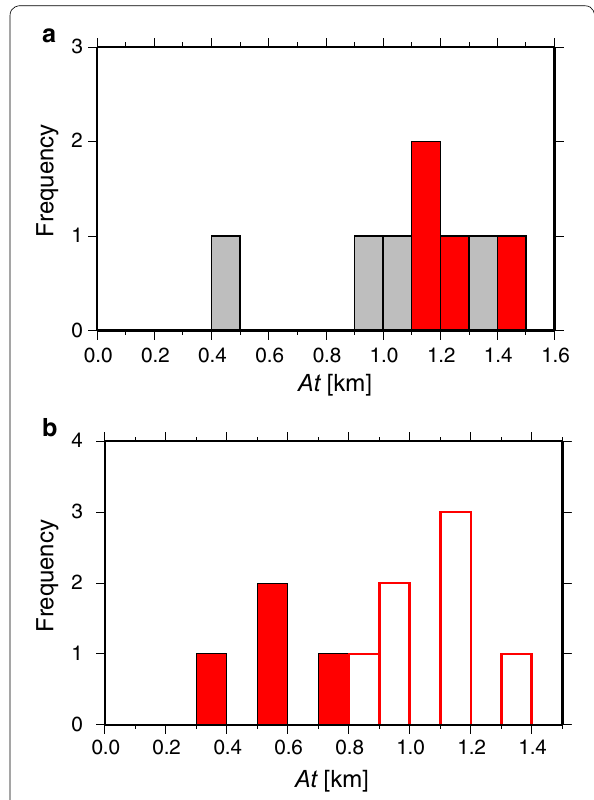
Fig. 7 Histograms showing A t . a Red and gray bins correspond to A t around the mainshock fault (Faults 1 through 4) and the best-fit planes in the northern part of the aftershock region (Faults 5 through 8), respectively. b Each bin shows A t around Faults 1 and 2 estimated using a smaller region for event selection. The solid and open bins indicate, respectively, A t with a planarity greater than or equal to 8 and A